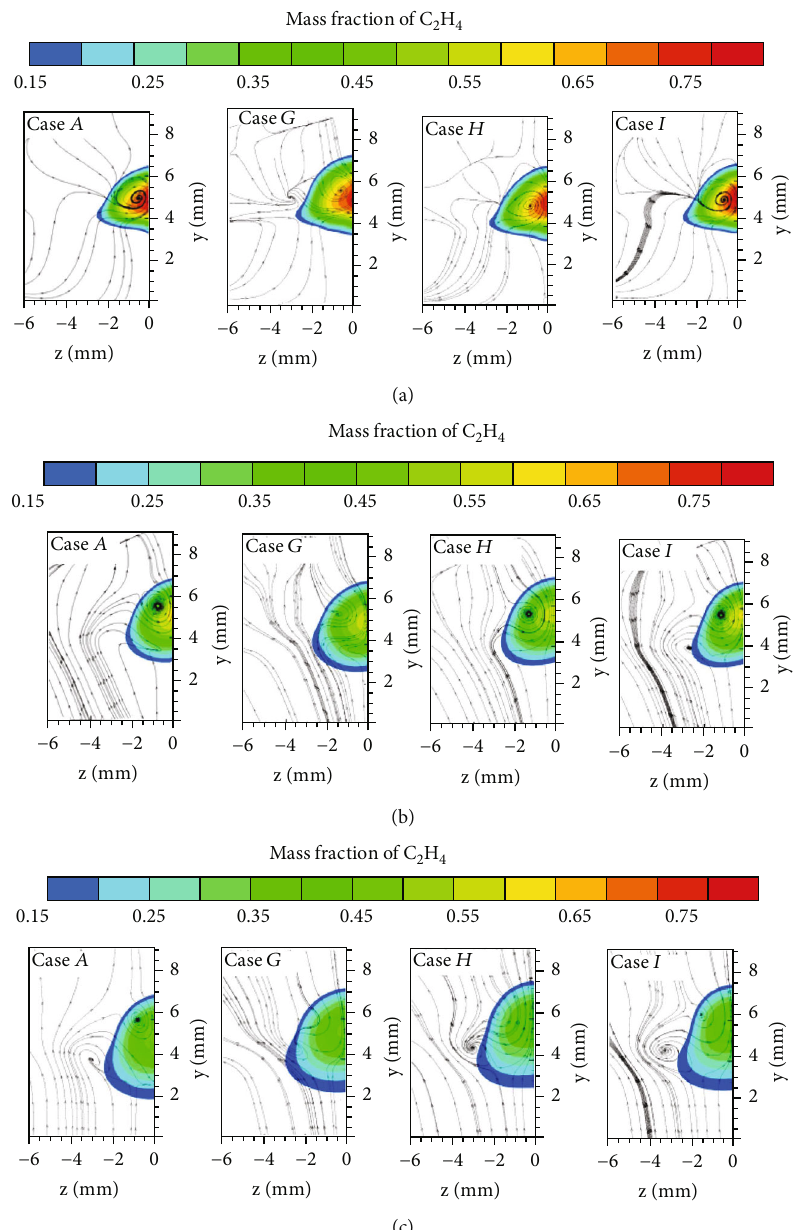
Figure 11: Mass fraction contour and streamline of case A and cases G - I at di ff erent planes. (a) x = 70mm . (b) x = 75mm . (c) x = 80mm